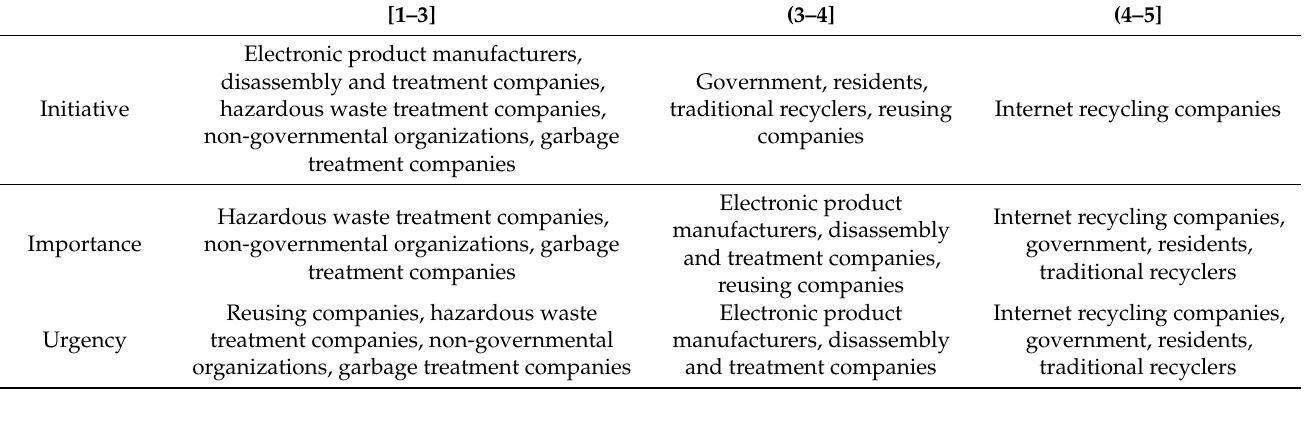
Table 7. Three-dimensional classification results of WEEE Internet recycling stakeholders.